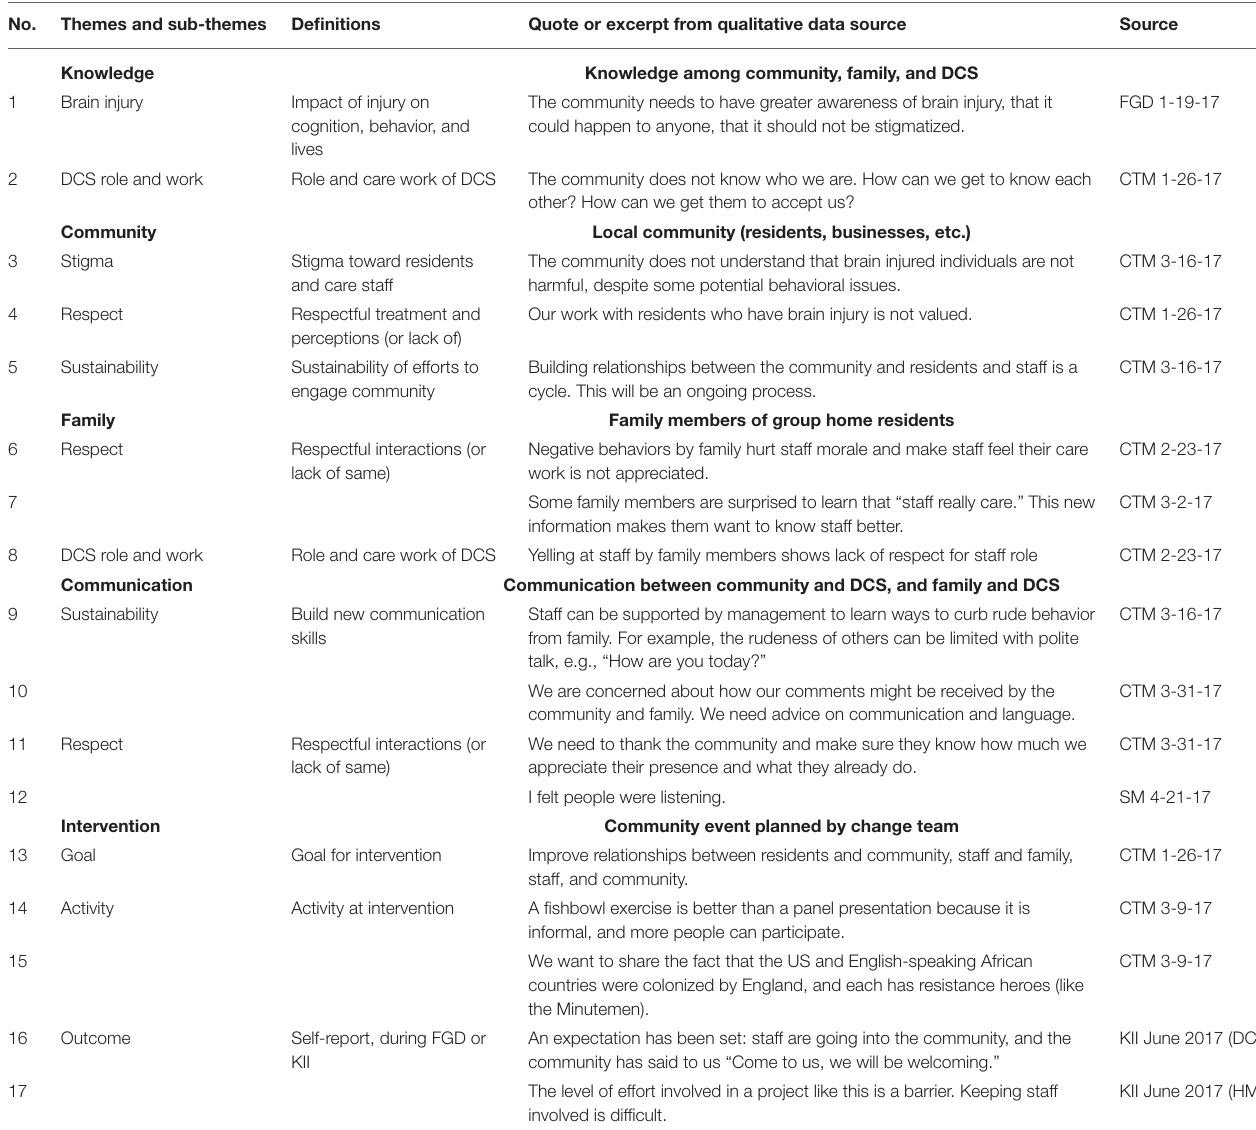
TABLE 3 | Themes, definitions, subthemes, excerpts, and sources: sample qualitative data